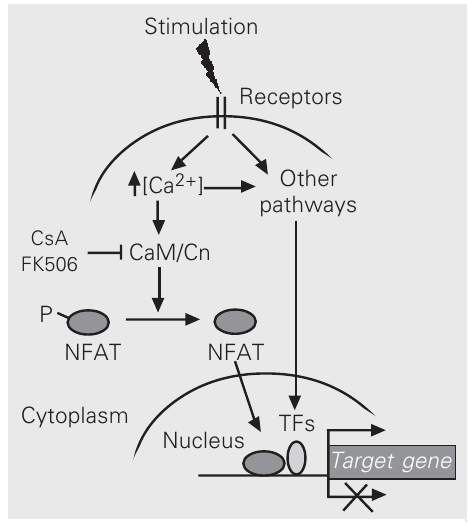
Figure 1. Schematic view of NFAT transcription factor signal- ing pathway in gene expression regulation. NFAT proteins are activated upon different stimuli that lead to increased intracellu- lar calcium levels. When de- phosphorylated by calcineurin, NFAT rapidly translocates to the nucleus where it regulates the expression of several target genes. NFATs may function as transcriptional activators or re- pressors and cooperate with several other transcription fac- tors. Ca 2+ = calcium; CaM = cal- modulin; Cn = calcineurin; CsA = cyclosporin A; NFAT = nuclear factor of activated T cells; P = phosphorylation; TFs = trans- cription